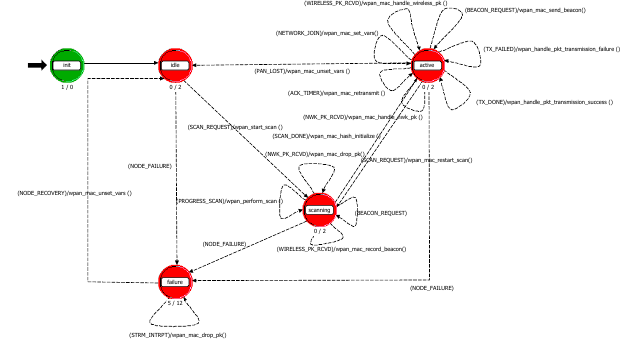
Figure 3. IEEE 802.15.4 MAC process model. Table 2. Two scenarios for the network